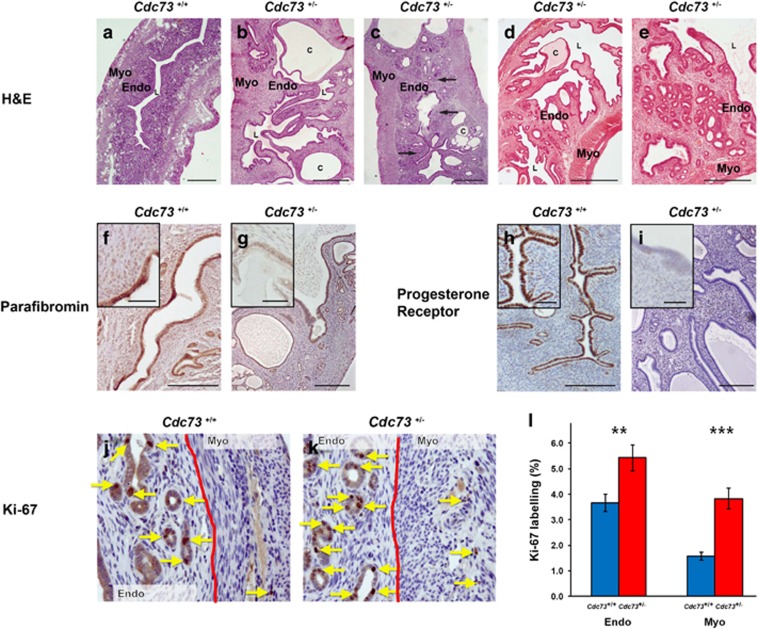
Uterine abnormalities develop in Cdc73+/− mice. (a) H&E-stained section of a uterus from a Cdc73+/+ mouse showing a normal myometrium (Myo), endometrium (Endo) and central lumen (l). (b, c) H&E-stained sections of uteri from Cdc73+/− mice with endometrial hyperplasia (b) and endometrial hyperplasia with squamous metaplasia (arrows) (c). Endometrial cysts (labelled c) and mucosal bridges traversing the lumen were observed in all the Cdc73+/− mice with neoplasms (b–e). (d) H&E-stained section of a uterine adenofibroma from a Cdc73+/− mouse with irregular polypoid endometrial projections into the lumen and cyst formation. (E) H&E-stained section of a uterine adenomyoma with glandular endometrium and irregular endometrial polyps projecting into the lumen. (f) Immunostaining for parafibromin in a section of a uterus from a Cdc73+/+ mouse demonstrating normal endometrial expression of parafibromin. (g) Parafibromin-stained sections of a uterine tumour from a Cdc73+/− mouse demonstrating reduced parafibromin expression in the endometrium. (h) Section of a uterus from a Cdc73+/+ mouse demonstrating normal expression of progesterone receptor in the endometrium. (i) Loss of endometrial progesterone receptor expression in a uterine tumour from a Cdc73+/− mouse. (j) Immunostaining for the proliferation marker Ki-67 in a section of a uterus from a Cdc73+/+ mouse (brown nuclei, arrows) with haemotoxylin nuclear counterstain. The interface of endometrium (Endo) and myometrium (Myo) is indicated by a solid red line. (k) Increased nuclear Ki-67 expression was observed in the endometrium and myometrium of uteri from Cdc73+/− mice with tumours (arrows). (l) Quantification of Ki-67 labelling index in the endometrium and myometrium of uteri from Cdc73+/+ mice (blue bars) and from Cdc73+/− mice with tumours (red bars) demonstrated significantly higher proliferation in Cdc73+/− mice (**P<0.01, ***P<0.001) compared to Cdc73+/+ mice (total (n=) fields of view from four mice per genotype for: Cdc73+/+ endometrium n=79, Cdc73+/− endometrium n=84, Cdc73+/+ myometrium n=78, and Cdc73+/− endometrium n=82). All scale bars represent 100 μm; insets have 400 × magnification.